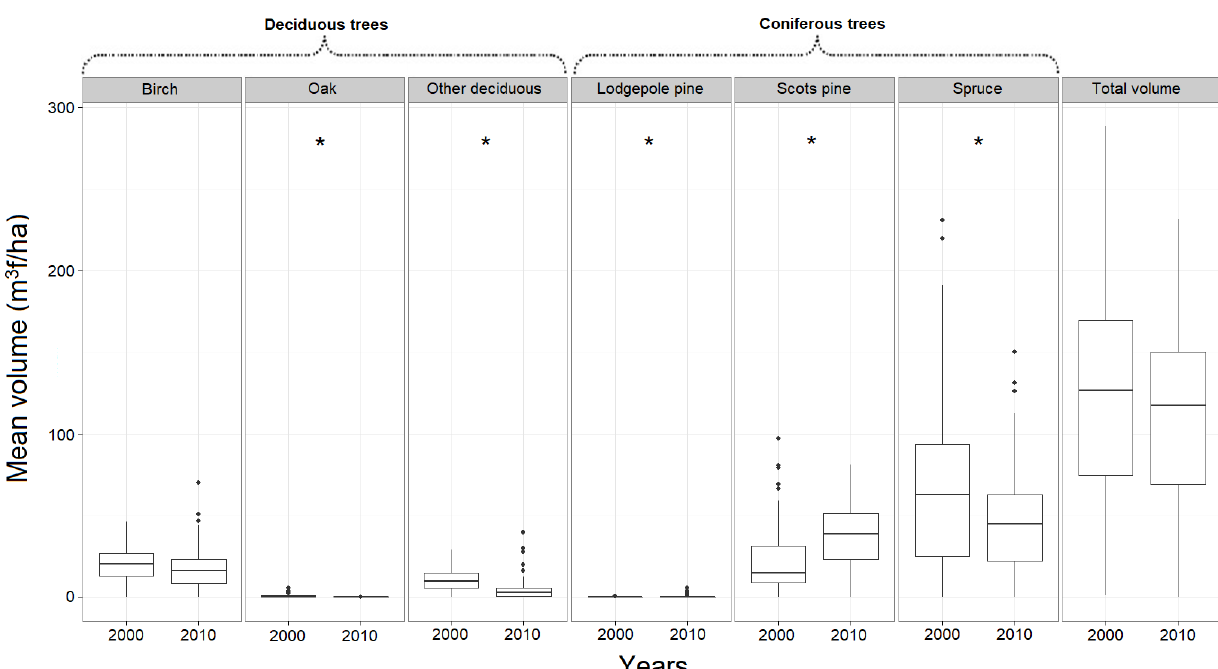
Figure 4. Boxplots of the mean volume in m 3 f/ha (cubic meter standing volume per hectare) in the sites selected for restoration for each of the tree species and all of the species combined, compared between the years 2000 and 2010. * denotes significant differences ( p ≤ 0.050).